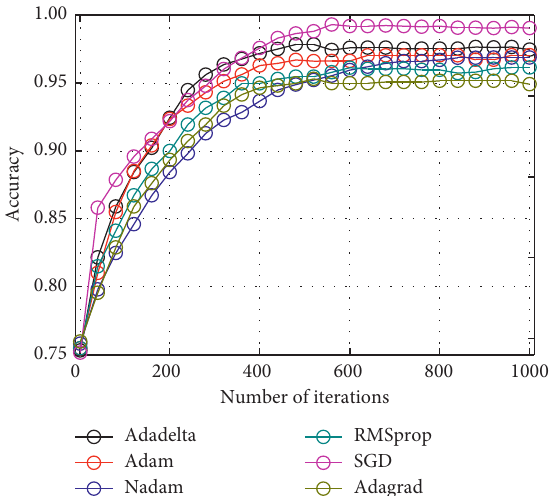
Figure 13: Comparison of recognition accuracy with different dropout values.